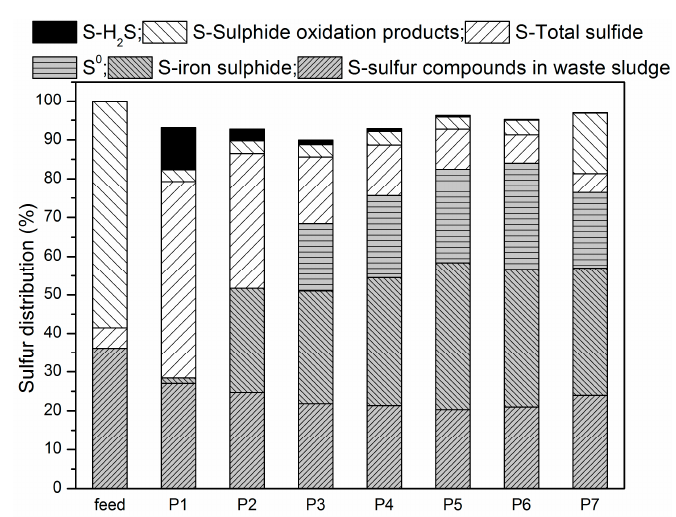
Figure 5. Calculated sulfur balance during semicontinuous anaerobic and microaerobic digestion of activated sludge supplemented with RSI over seven periods of operation associated with stepwise increases in oxygen concentration: (1) sulfur compounds in waste sludge; (2) iron sulphide precipitation; (3) elemental sulfur S 0 ; (4) sulfide in liquid phase; (5) sulphide oxidation products; and (6) sulfur in biogas.